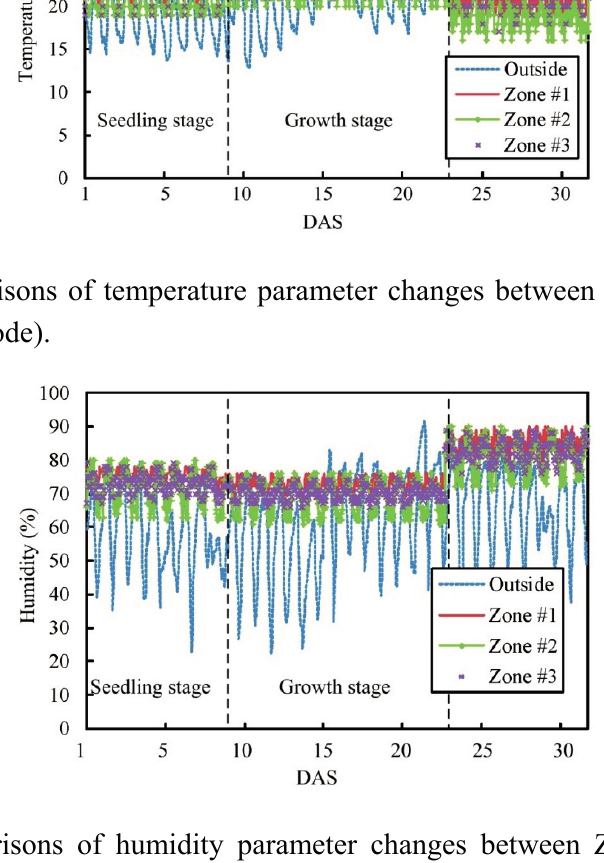
Figure 13. Comparisons of humidity parameter changes between Zone #1 to Zone #3 (under automatic